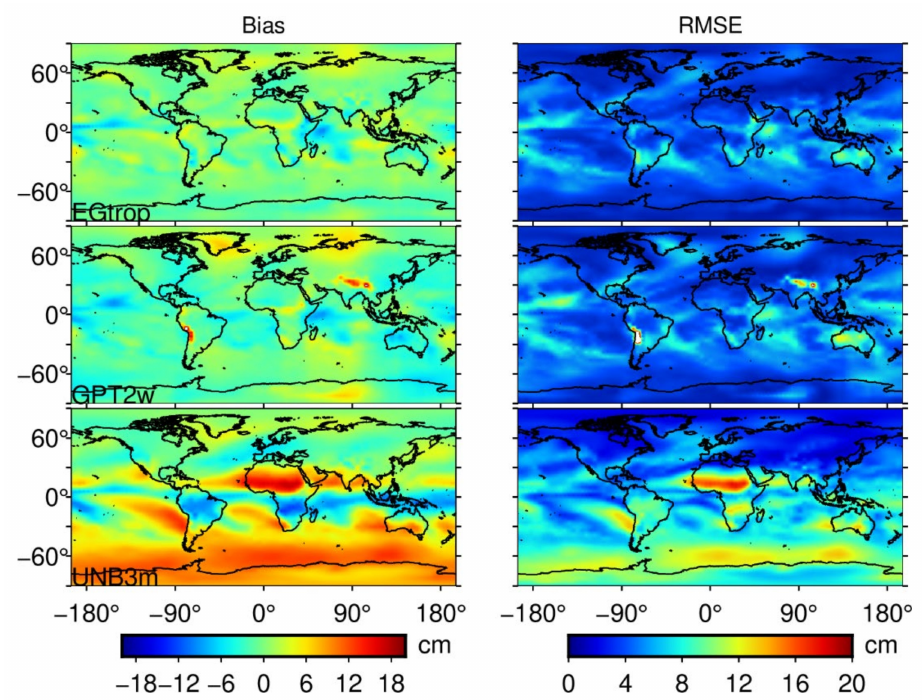
Figure 8. Error distribution map of each model compared to the global ERA-5 ZTD product over 2020. The left side of the picture is the Bias distribution diagram, and the right side is the RMSE distribution diagram. From top to bottom are the error distributions of the EGtrop, GPT2w and